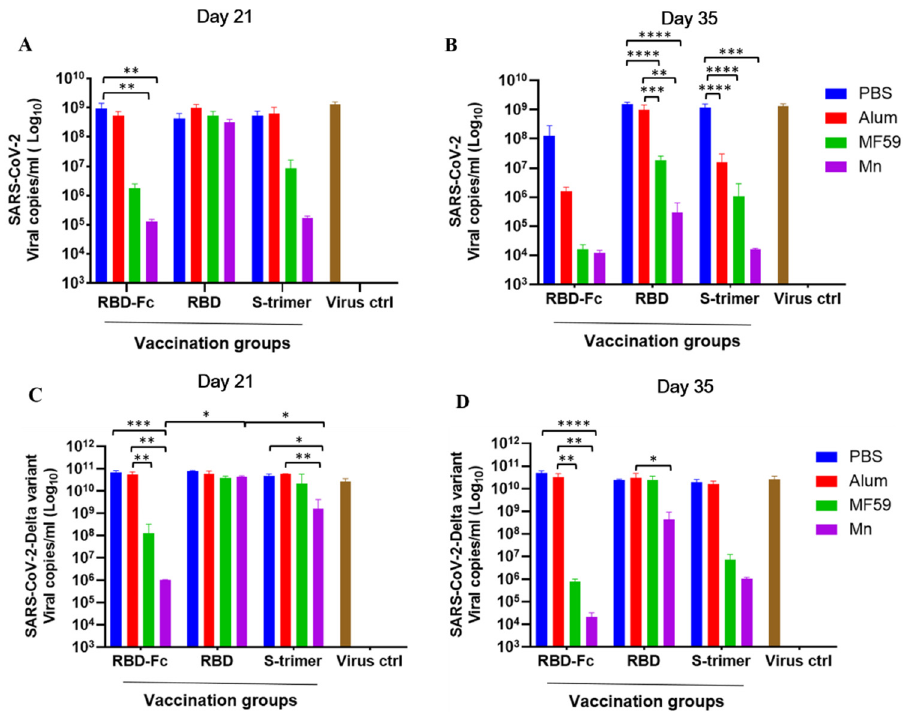
Figure 5. Viral load reduction assay in vaccinated mouse sera on days 21 and 35 against both the authentic SARS-CoV-2 wildtype (HKU-001a strain) and Delta variant. VeroE6-TMPRSS2 cells were used for viral infection, and the virus copies in the cell culture supernatants were quantified by real-time one-step (qRT-PCR). ( A ) Viral load reduction assay on SARS-CoV-2 wildtype (HKU-001a strain) by mouse sera collected on day 21. ( B ) Viral load reduction assay on SARS-CoV-2 wild-type (HKU-001a strain) by mouse sera collected on day 35. ( C ) Viral load reduction assay on SARS-CoV-2 Delta variant by mouse sera collected on day 21. ( D ) Viral load reduction assay on SARS-CoV-2 Delta variant by mouse sera collected on day 35. Statistical significance was determined by two-way ANOVA and is indicated as follows: * p < 0.05, ** p < 0.01, *** p < 0.001, **** p < 0.0001. Error bars represent SD.